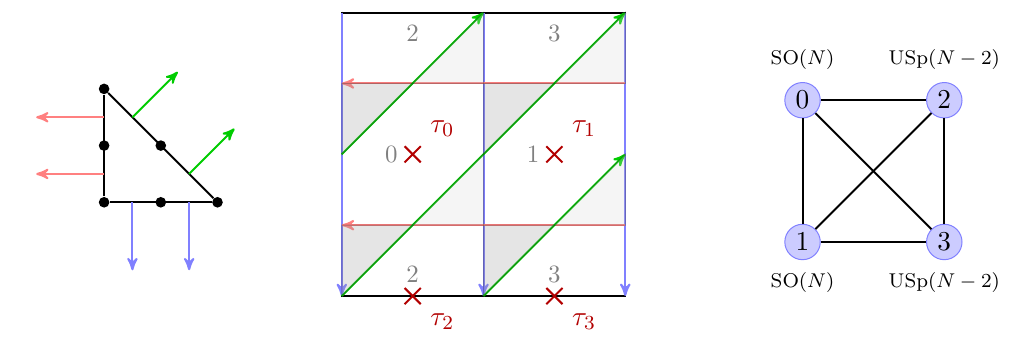
Figure 30. The model L 0 , 2 , 0 / Z 2 . On the left the toric diagram is drawn, at the center the five- brane and its orientifold projection with fixed points, on the right the quiver resulting from the orientifold